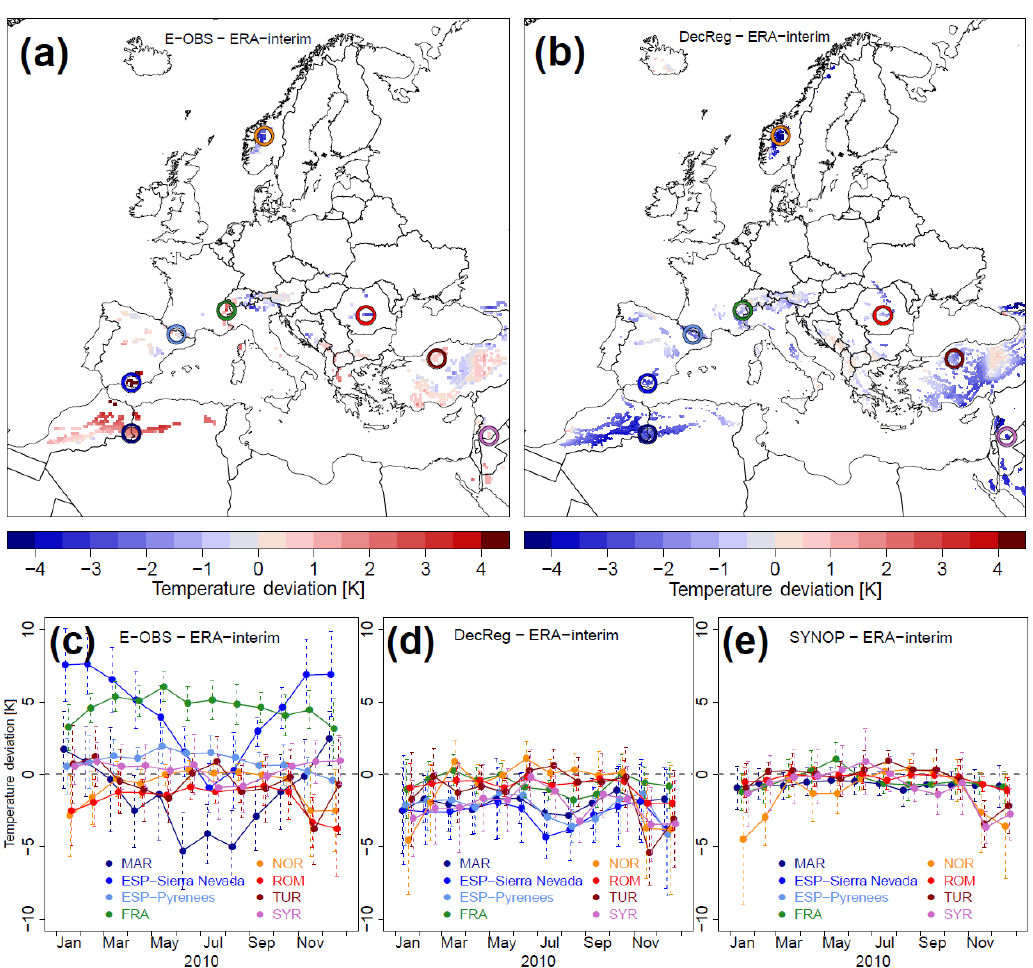
Figure 21. Comparison of daily temperature grid data at altitudes of around 1500m from DecReg and E-OBS with ERA-Interim 850hPa temperatures for January 2010: (a) E-OBS minus ERA-Interim mean deviations of daily mean temperatures ( T avg ); (b) DecReg minus ERA- Interim mean deviations of daily T avg ; (c) annual cycle of E-OBS minus ERA-Interim deviations of daily T avg (monthly mean and standard deviation) at single grid points encircled in panel (a) ; (d, e) same as in panel (c) but for the comparison DecReg minus ERA-Interim and SYNOP minus ERA-Interim,